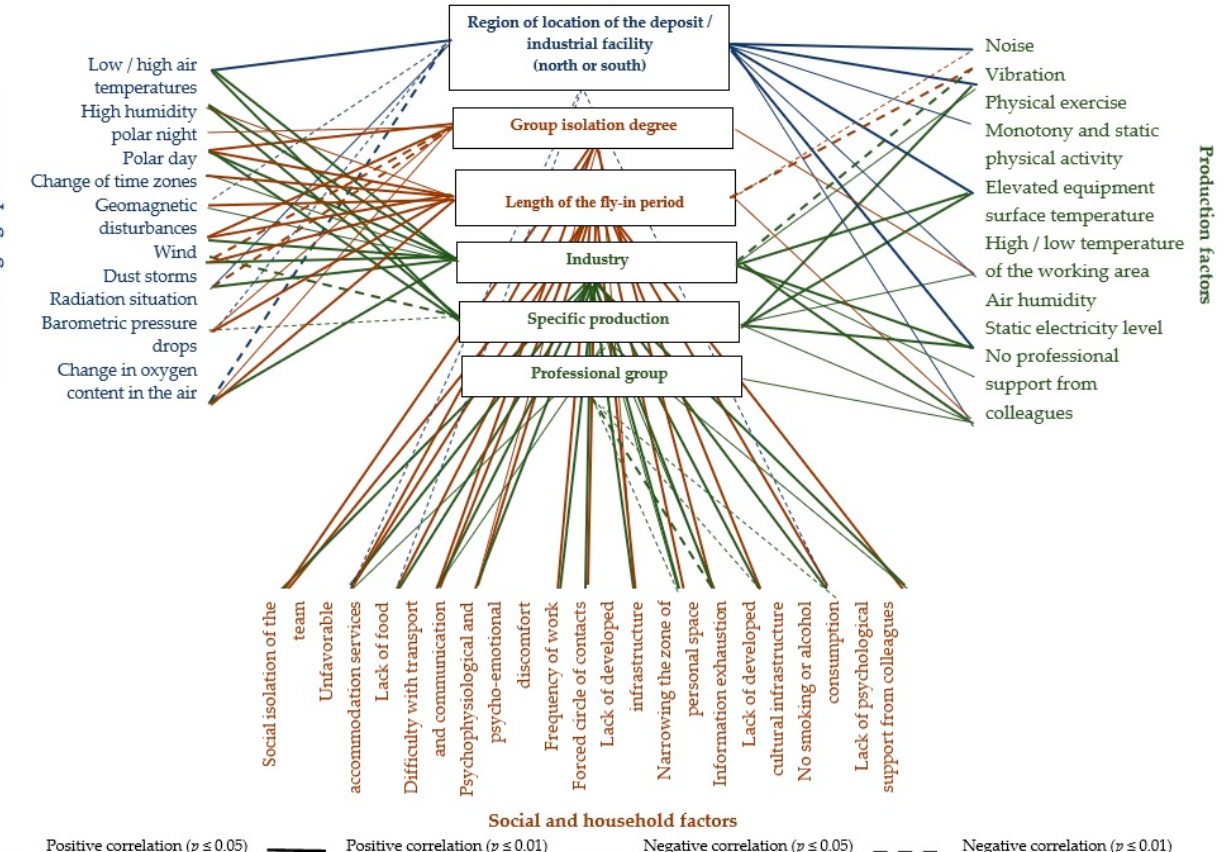
Figure 5. Correlation pleiad of interconnection of the impact of adverse environmental factors with different levels of differential analysis of professional activities of FIFO personnel.